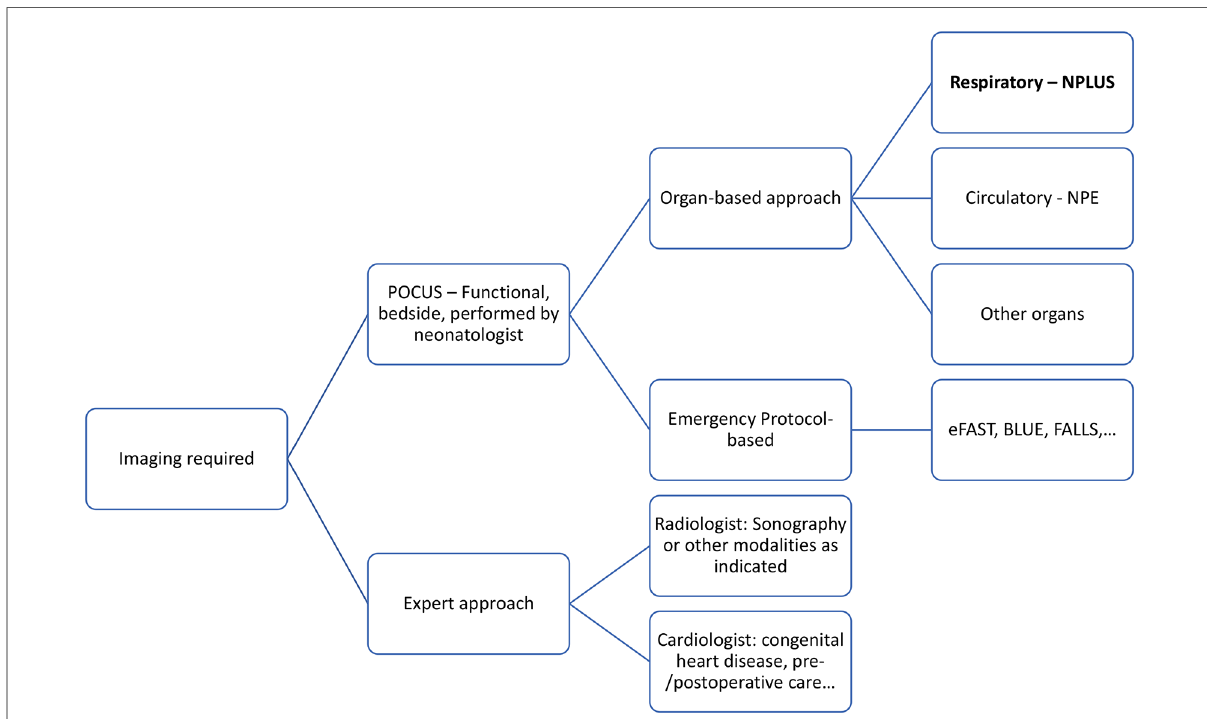
FIGURE 1 Decision tree for sonographic imaging of neonates. Two approaches (POCUS and expert approach) are further investigated. At the bedside, POCUS may provide quick answers regarding speci fi c, organ-related questions by scanning the corresponding region or by application of an emergency protocol (e.g., respiratory insuf fi ciency, intracranial haemorrhage, cardiac tamponade). In analogy to NPLUS and NPE, other organ-based exams might follow this nomenclature. Expert approach allows for a more thorough and sophisticated diagnostic evaluation, but might be more time- consuming and depends on the availability of skills and